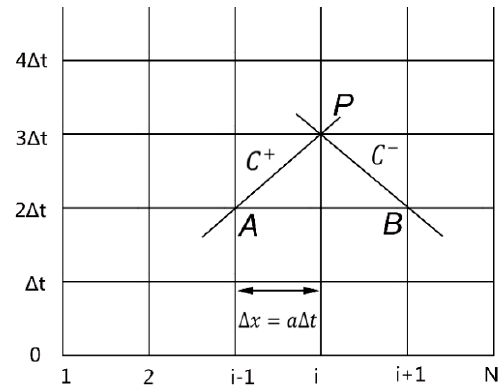
Figure 2. Difference mesh for the method of characteristic.